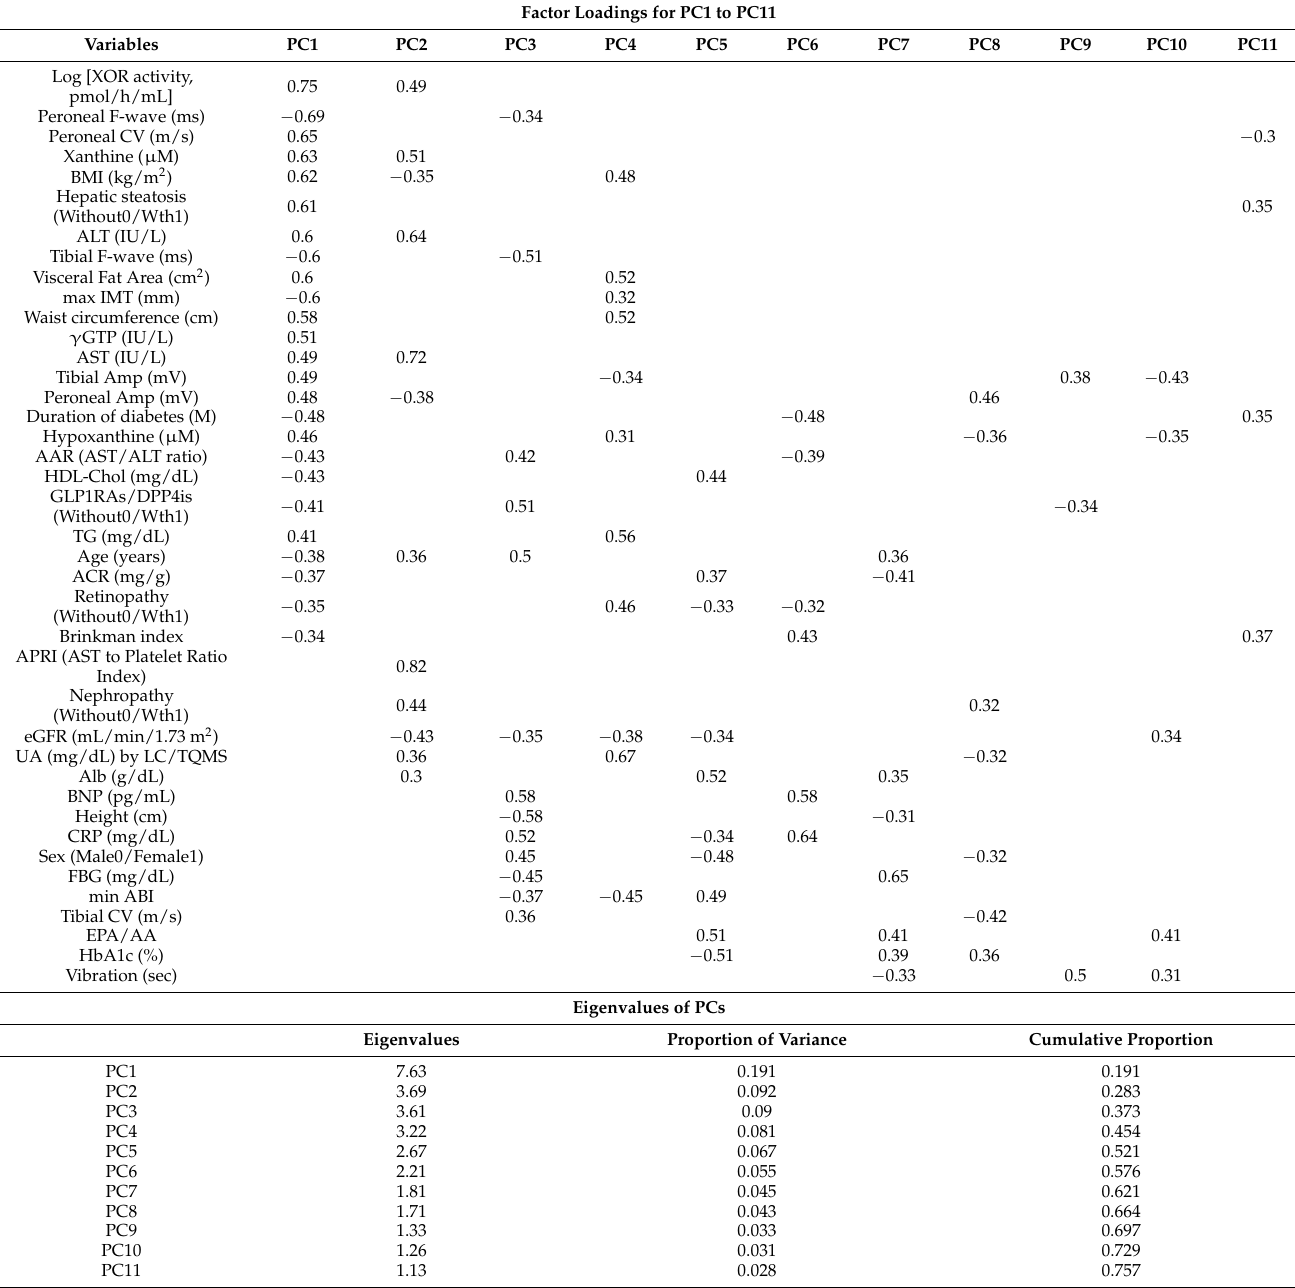
Table 3. Principal component analysis (PCA). Factor Loadings for PC1 to